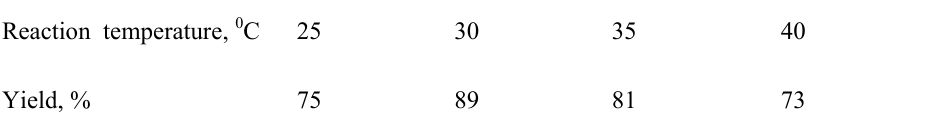
Table 4 The effect of reaction temperature on the oxidation of cyclohexanol to adipic acid under ultrasound irradiation*.